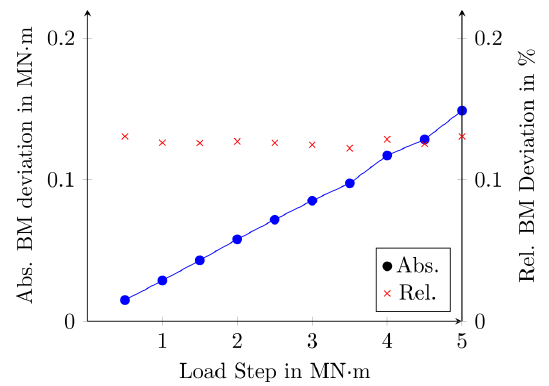
Figure 8. Expected bending moment deviation on MF.